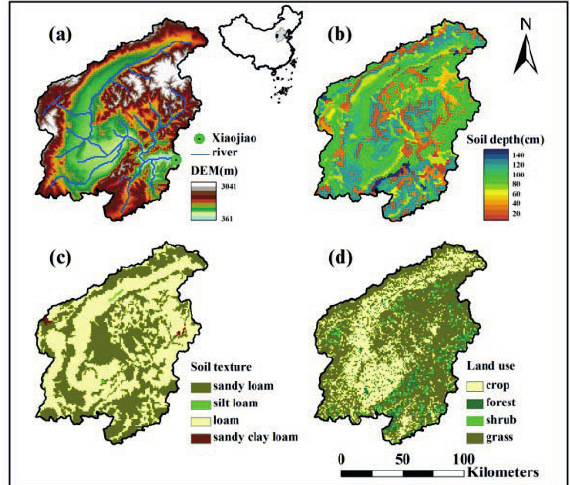
Fig . 1 The DEM (a), soil depth (b), soil texture (c) and land use (d) of HRB with Xiaojue hydrological station as outlet in Hai River basin (the grey area in the inserted map),